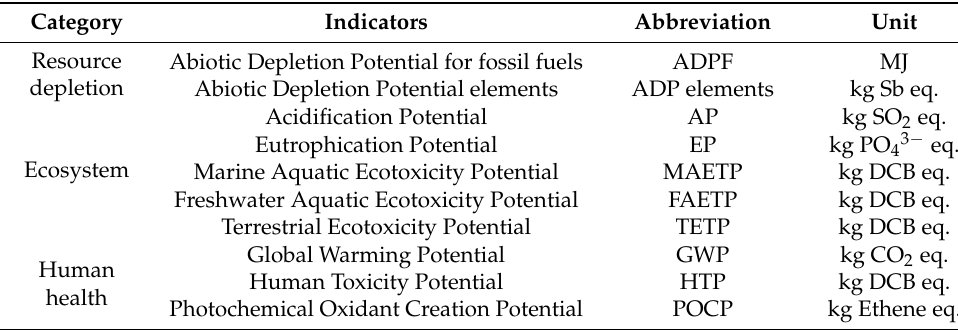
Table 1. Indicators of life cycle impact